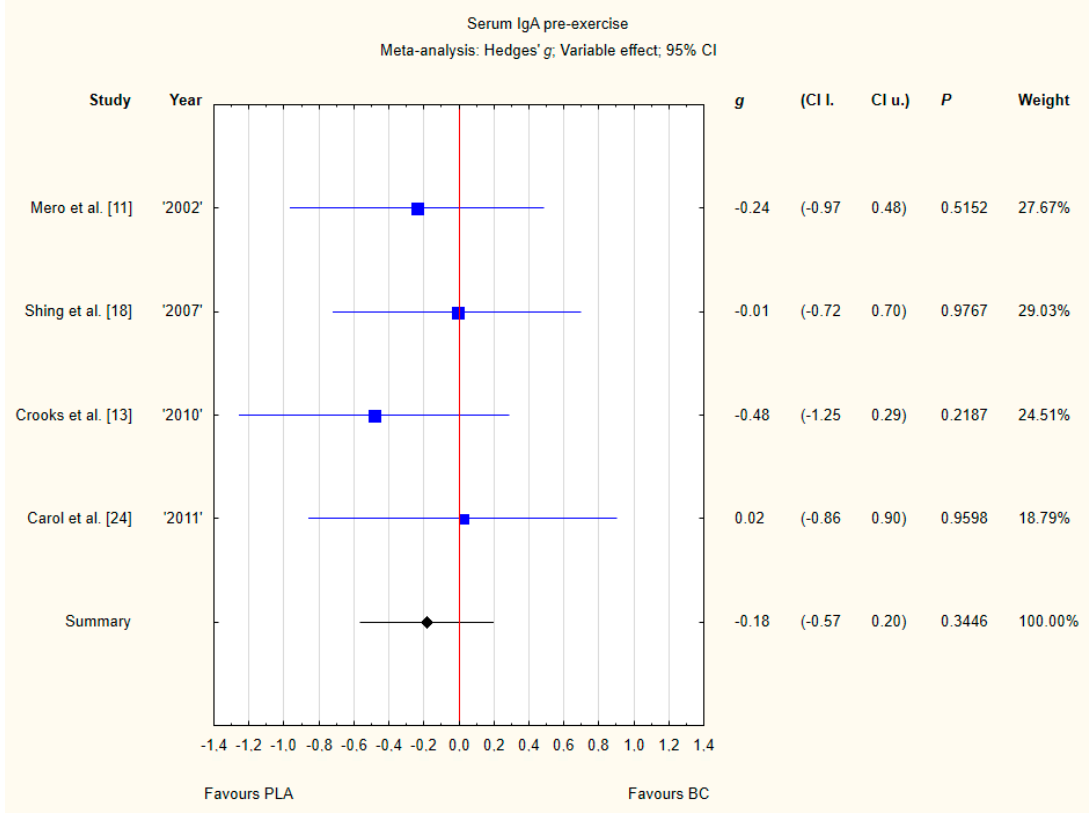
Figure 6. Forest plot of the random-effects meta-analysis of changes in IgA concentration. Heterogeneity: Tau 2 = 0; Chi 2 = 1.05; df = 3; I 2 = 0%; P = 0.79. Abbreviations: BC–bovine colostrum, IgA–Immunoglobulin A, PLA–placebo.